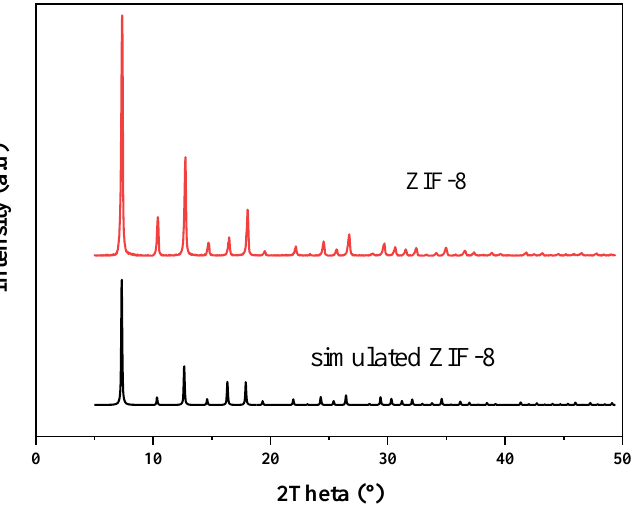
Figure 2. XRD spectra of ZIF-8. Figure 3 represents the FTIR spectra of the synthesized ZIF-8. In the structure of ZIF-8, the weak tensile vibrations at 3134 cm − 1 and 2925 cm − 1 represent the aromatic and aliphatic C-H bonds, respectively. The strong weak vibration near 2933 cm − 1 is caused by the ring stretching of imidazole groups. The peak value at 1587 cm − 1 is related to the stretching vibration of C-N bond. The value at 754 cm − 1 corresponds to the Zn-O bond, and the value at 1147 cm − 1 corresponds to the C-N bond. The stretching vibration peak of Zn-N is at 422 cm − 1